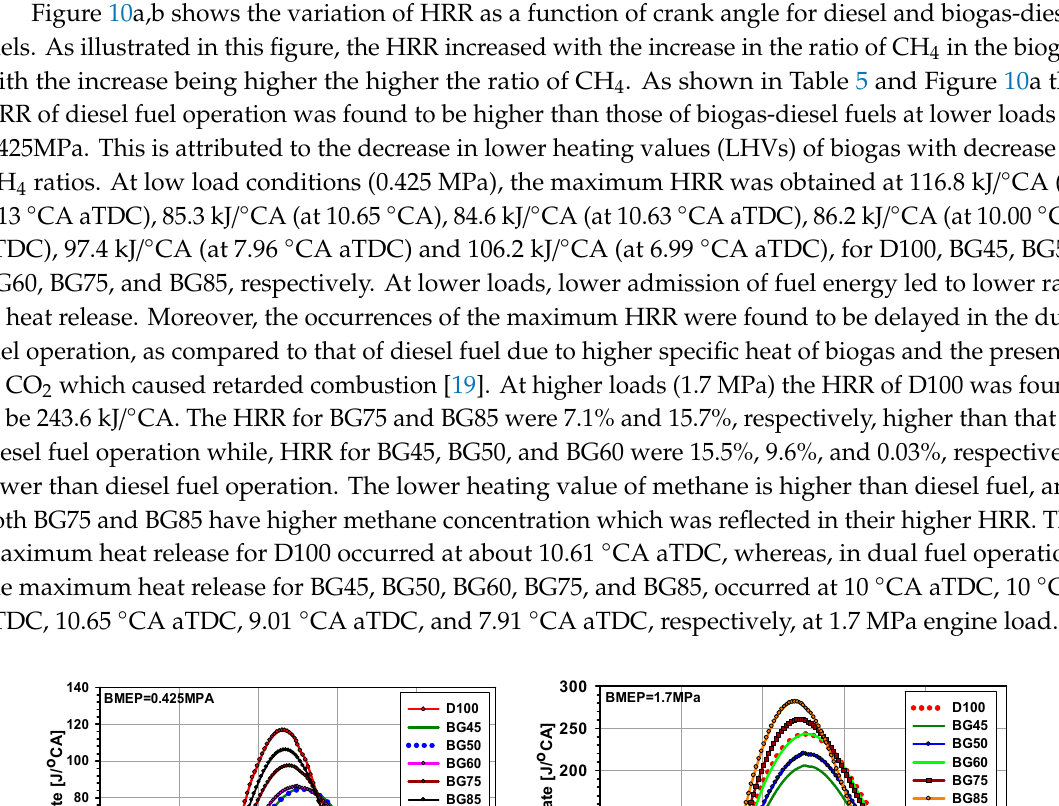
Figure 9. Position of pressure peak.